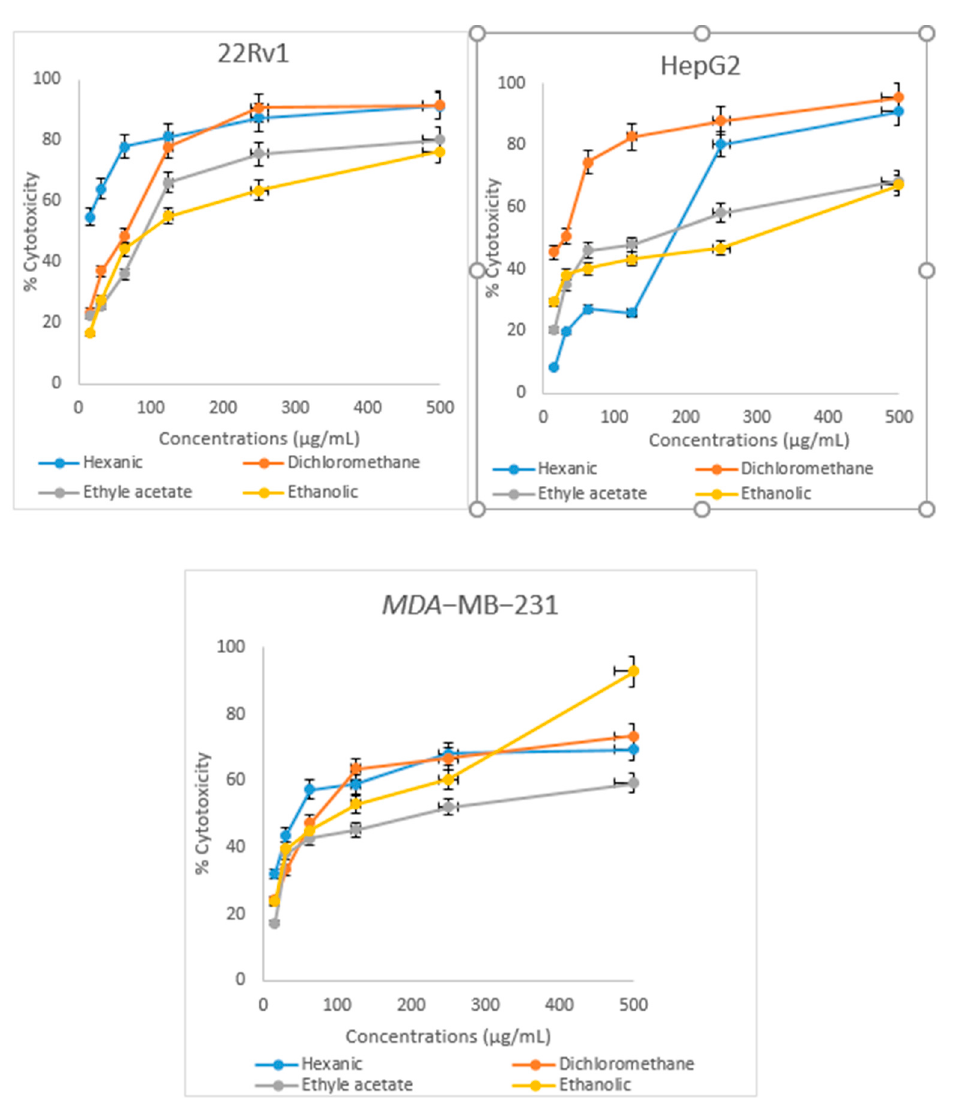
Figure 4. Antiproliferative activity of Cistus ladanifer extracts using the MTT assay for 22Rv1, HepG2 and MDA-MB-231 cell lines.